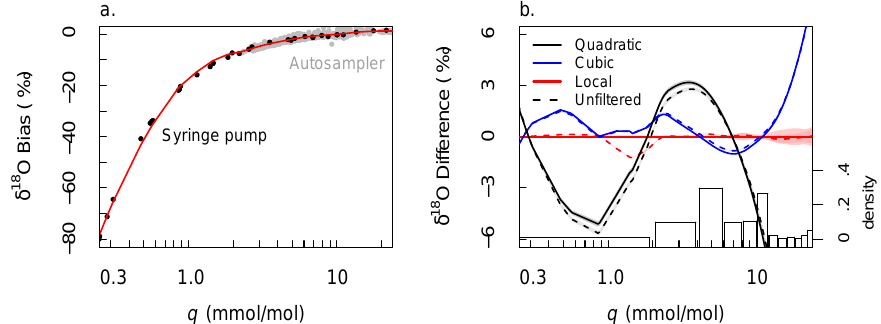
Figure 1. (a) The concentration dependence of the Mauna Loa analyzer shown with both the autosampler (gray) and syringe-pump (black) calibration points normalized to a reference humidity (see Sect. 2.4). The red line is the locally weighted polynomial regression used as the reference curve in panel (b) . (b) Curve-fitting and hysteresis effects on the Mauna Loa concentration-dependence characterization. Lines represent the calibration differences that would result if fitting a quadratic (black) or cubic (blue) polynomial instead of a locally weighted polynomial regression (red). All are shown as a function of q – the water vapor volume mixing ratio – on a log scale. Curves fit to all data (unfiltered for hysteresis) are represented by dashed lines. Curves fit to filtered data are represented by solid lines. Prediction errors are represented by shaded envelopes around each curve. The calibration data density is depicted by bars (rightmost